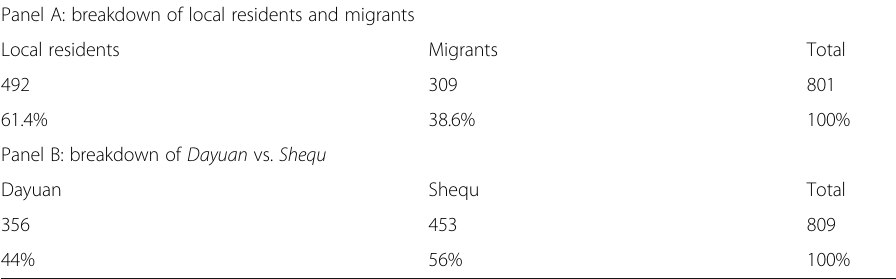
Table 3 Distribution of subgroups Panel A: breakdown of local residents and migrants Local residents Migrants Total 492 309 801 61.4% 38.6% 100% Panel B: breakdown of Dayuan vs. Shequ Dayuan